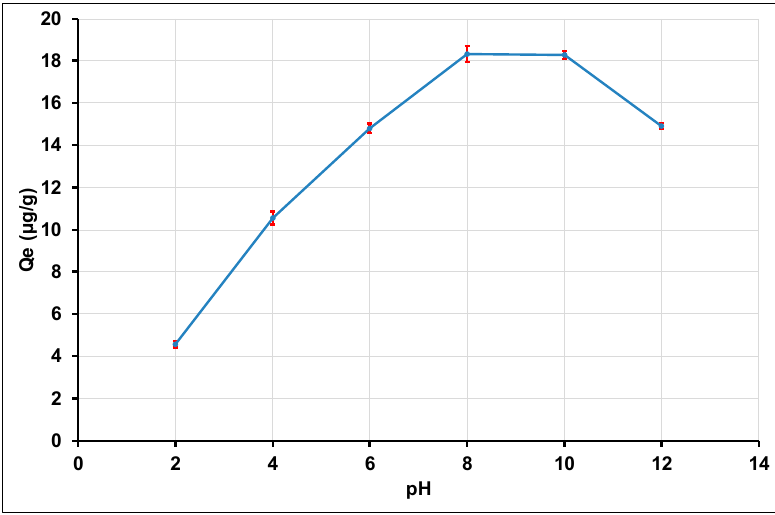
Figure 6. Effect of initial pH on the adsorption of Tl(I) by γ ANPs.